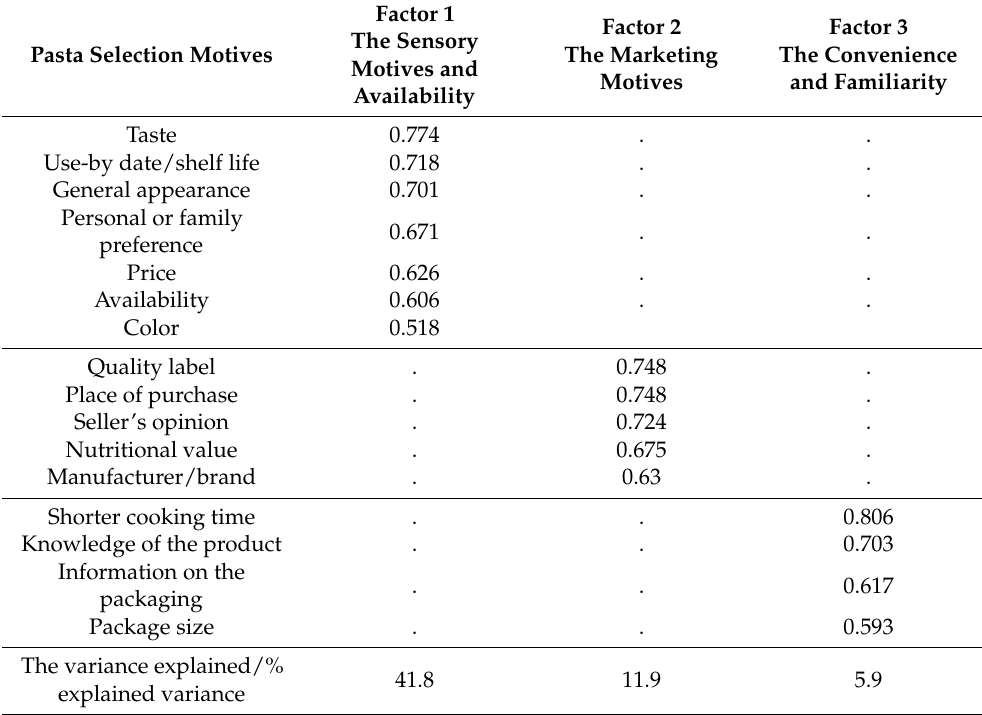
Table 1. Factor analysis (FA) referring to consumers’ use of pasta selection motives; varimax rotated factor loadings percentage of explained variance ( N = 1013,